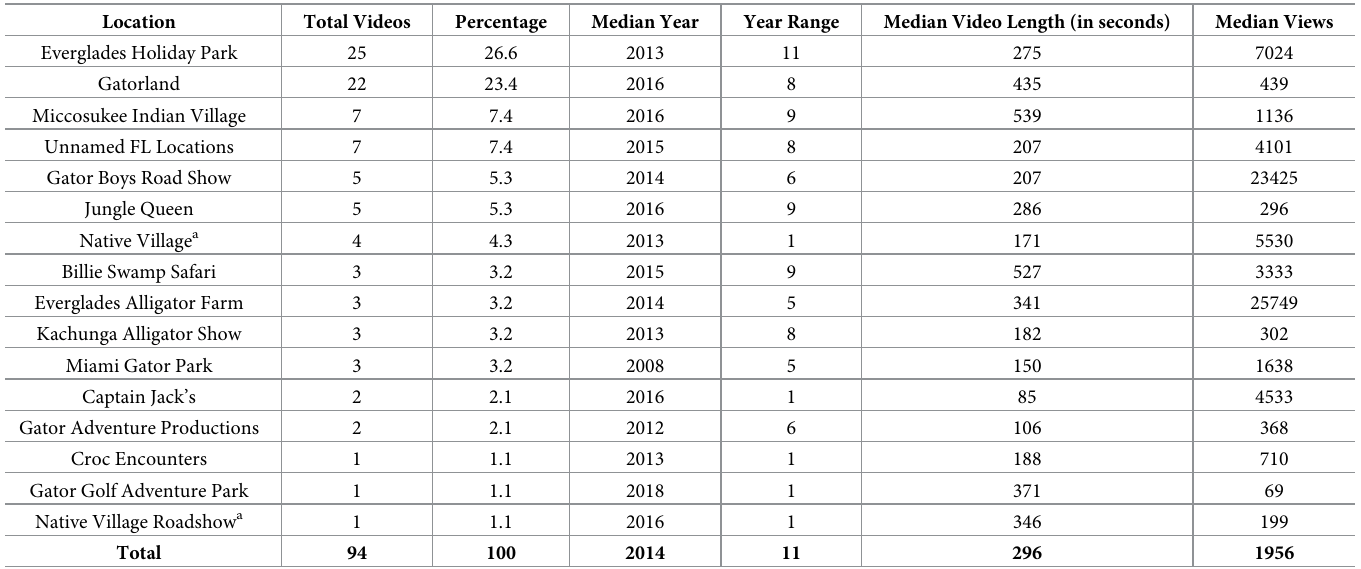
Table 1. Characteristics of YouTube videos in the